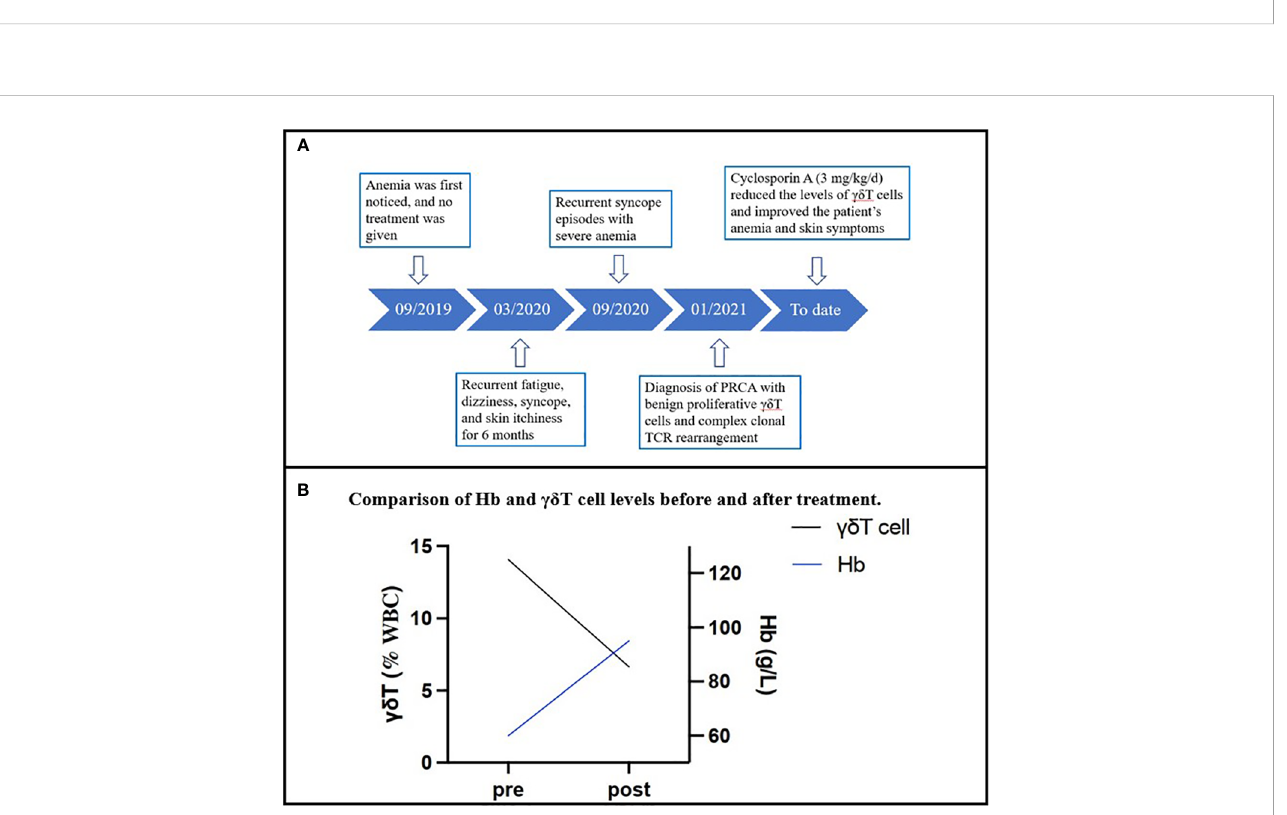
FIGURE 2 (A) The timeline of the case. (B) The change in the patient ’ s hemoglobin levels and gd T cell percentage in the total T-cell component in the peripheral blood sample over 10